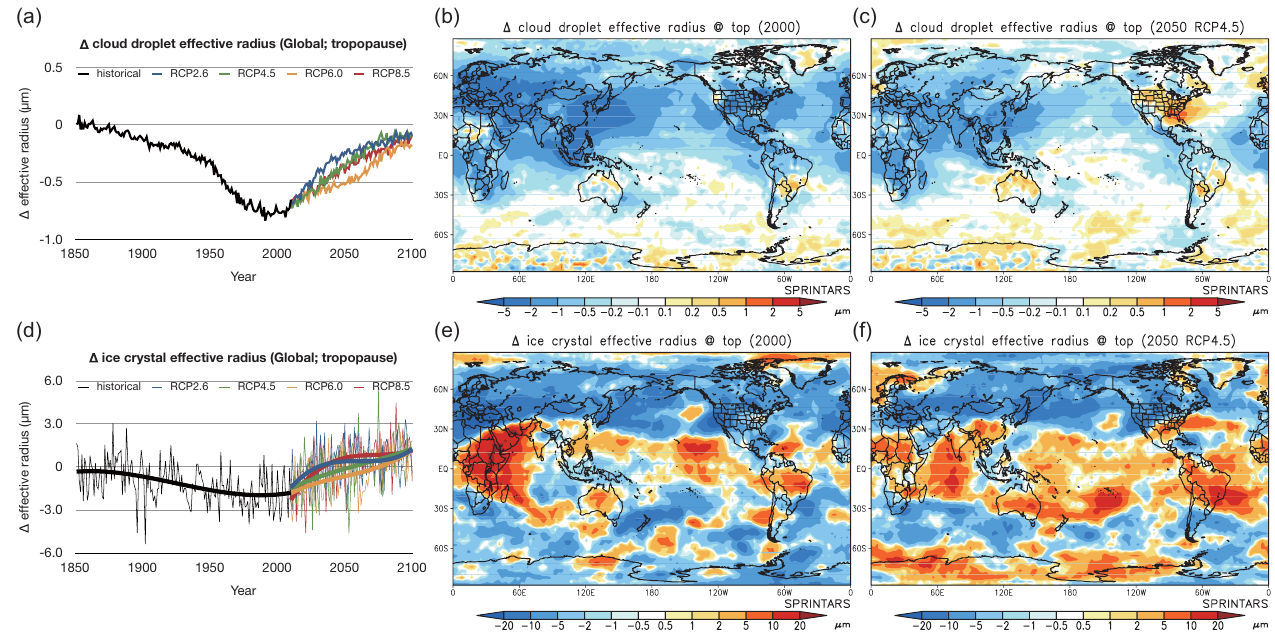
Fig. 12. Time series of annual and global mean effective radii at the cloud top of (a) cloud droplets and (d) ice crystals, and global distributions of changes in effective radii of (b) cloud droplets and (e) ice crystals in 2000 (averaged over the period 1998–2002) and (c) cloud droplets and (f) ice crystals in 2050 (averaged over the period 2048–2052) for the RCP4.5 experiment relative to the preindustrial experiment simulated by SPRINTARS. In (a) and (d) , historical period is shown in black, and the four RCPs are shown in colours. In (d) , thick lines are regression curves.